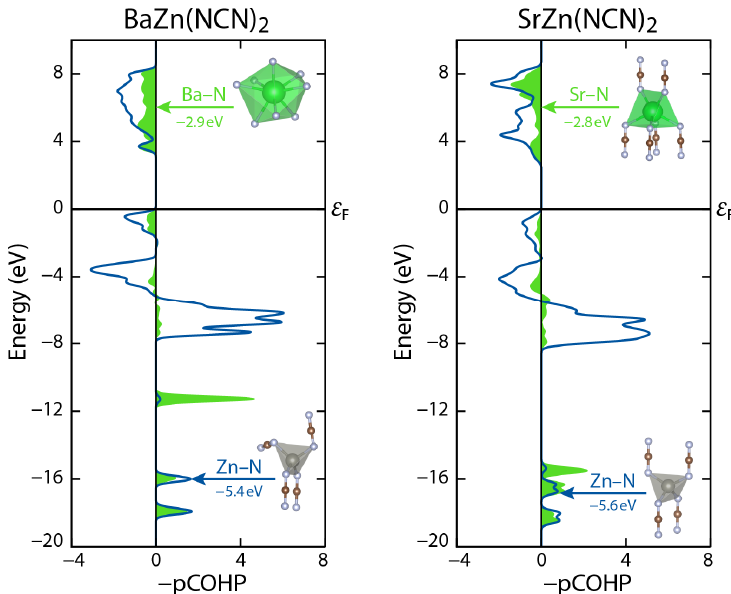
Figure 6. Crystal orbital Hamilton population (COHP) analysis of BaZn(NCN) 2 and SrZn(NCN) 2 .